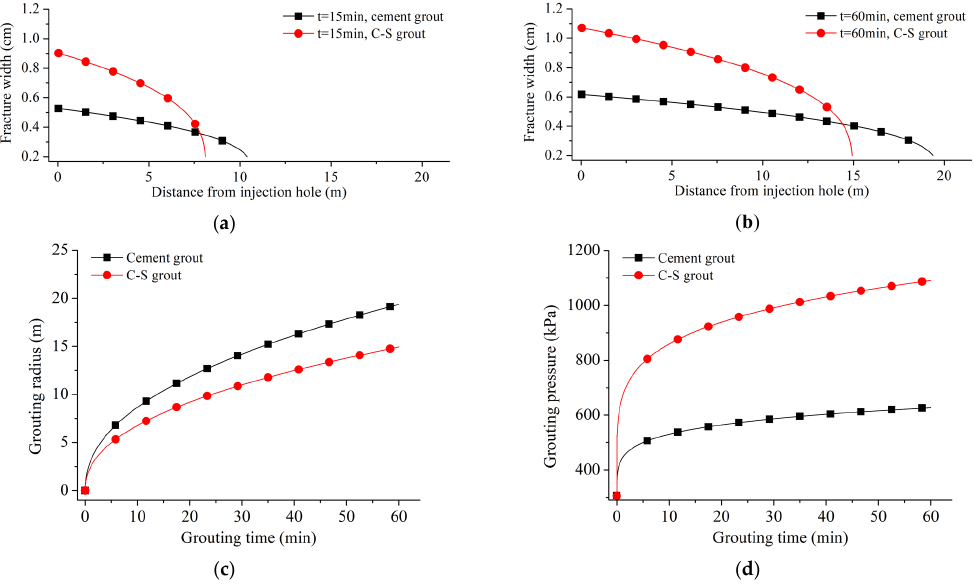
Figure 14. Comparison on diffusion characteristics of two grouts. ( a ) Fracture width (t = 15 min). ( b ) Fracture width (t = 60 min). ( c ) Grouting radius. ( d ) Grouting pressure.